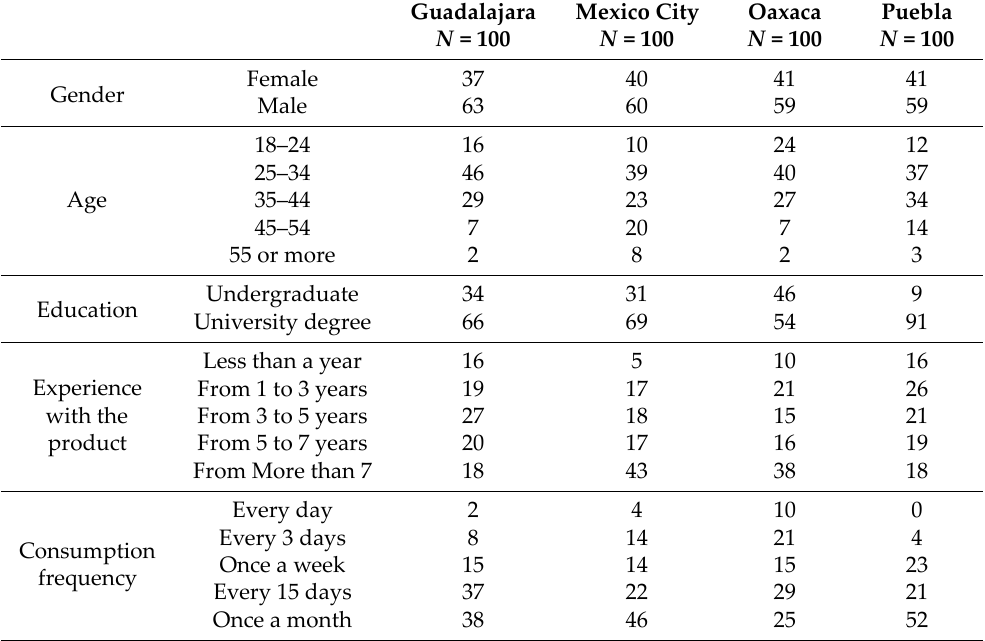
Table 1. Sample characteristics (number of